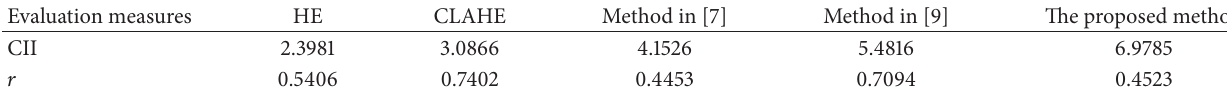
Table 1: The comparison of CII and 𝑟 with different methods on the image shown in Figure 3(a).